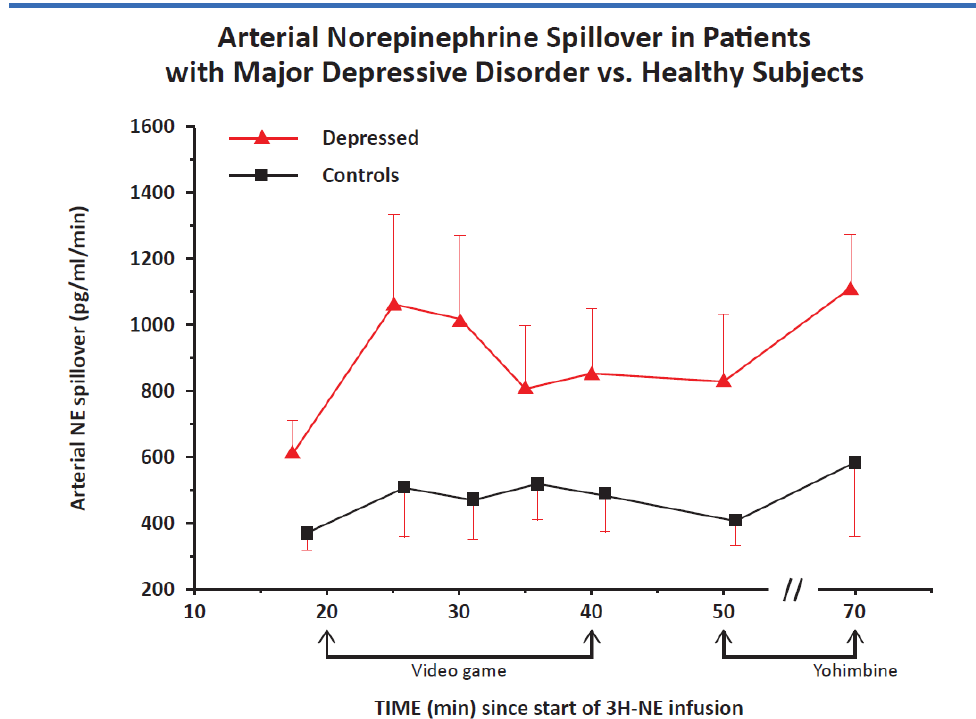
Figure 2. Norepinephrine spillover into arterial plasma corrected for norepinephrine clearance at baseline, during the stress of a video game, and after the infusion of yohimbine, an a-2 noradrenergic antagonist that increases the secretion of norepinephrine by blocking the inhibitory norepinephrine a-2 receptor ( p < 0.01) for all findings).